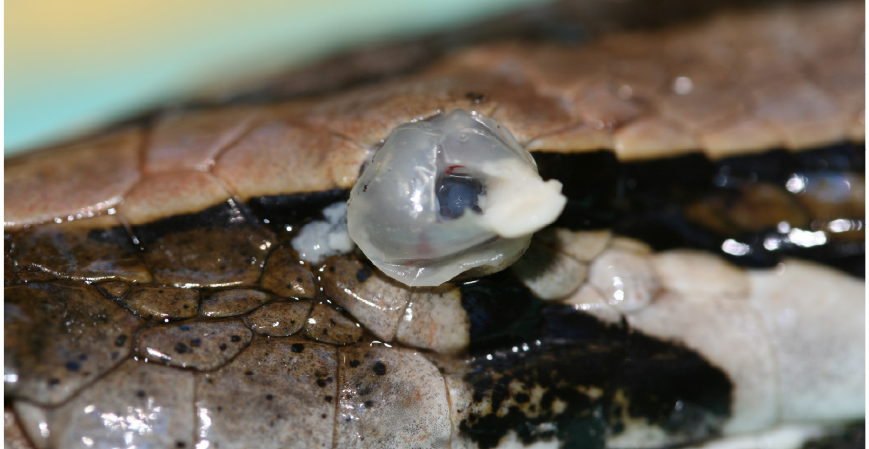
Figure 41. Collapse and wrinkling of the spectacle after performing a partial spectaculectomy and removal of the exudate in a Burmese python ( Python bivittatus ) are frequently seen in cases of chronic infection.